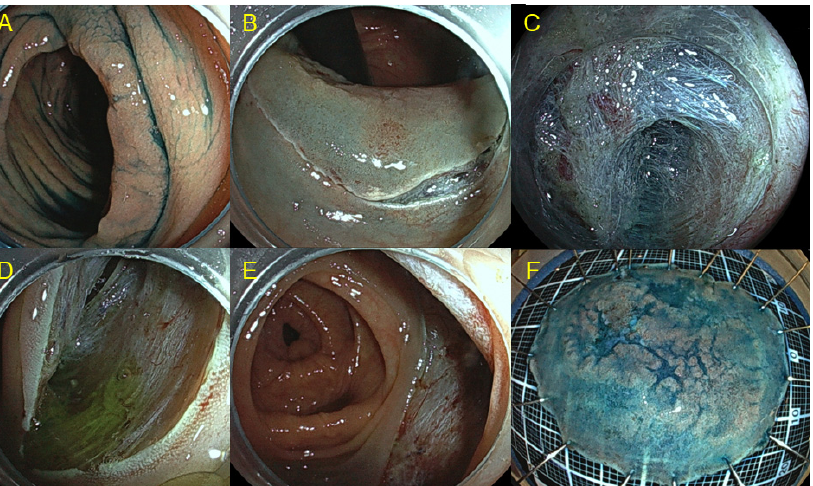
Figure 1. Colorectal endoscopic submucosal dissection (ESD) using pocket creation method. ( A ) Laterally spreading tumor in the ascending colon. ( B ) Mucosal incision was made around the oral side with retroflex view. ( C ) A submucosal pocket was created by dissecting the submucosa. ( D ) Submucosal tunnel was created from the anal to oral side. ( E ) Post-operative ulcer after ESD. ( F ) Specimen after ESD (complete resection, superficial submucosal invasive cancer).